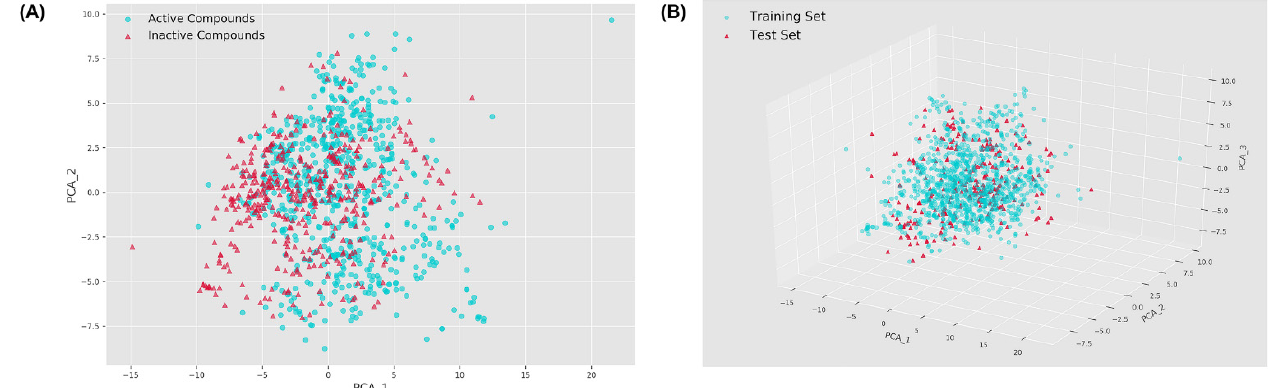
Figure 1. Visualization of the two-dimensional distribution of active and inactive compounds ( A ) and the three-dimensional distribution of training and test sets ( B ).